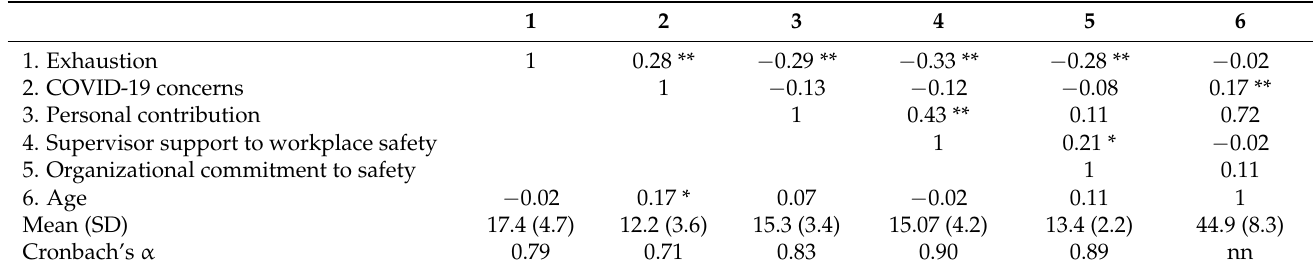
Table 1. Correlations among the study variables, descriptive and reliability